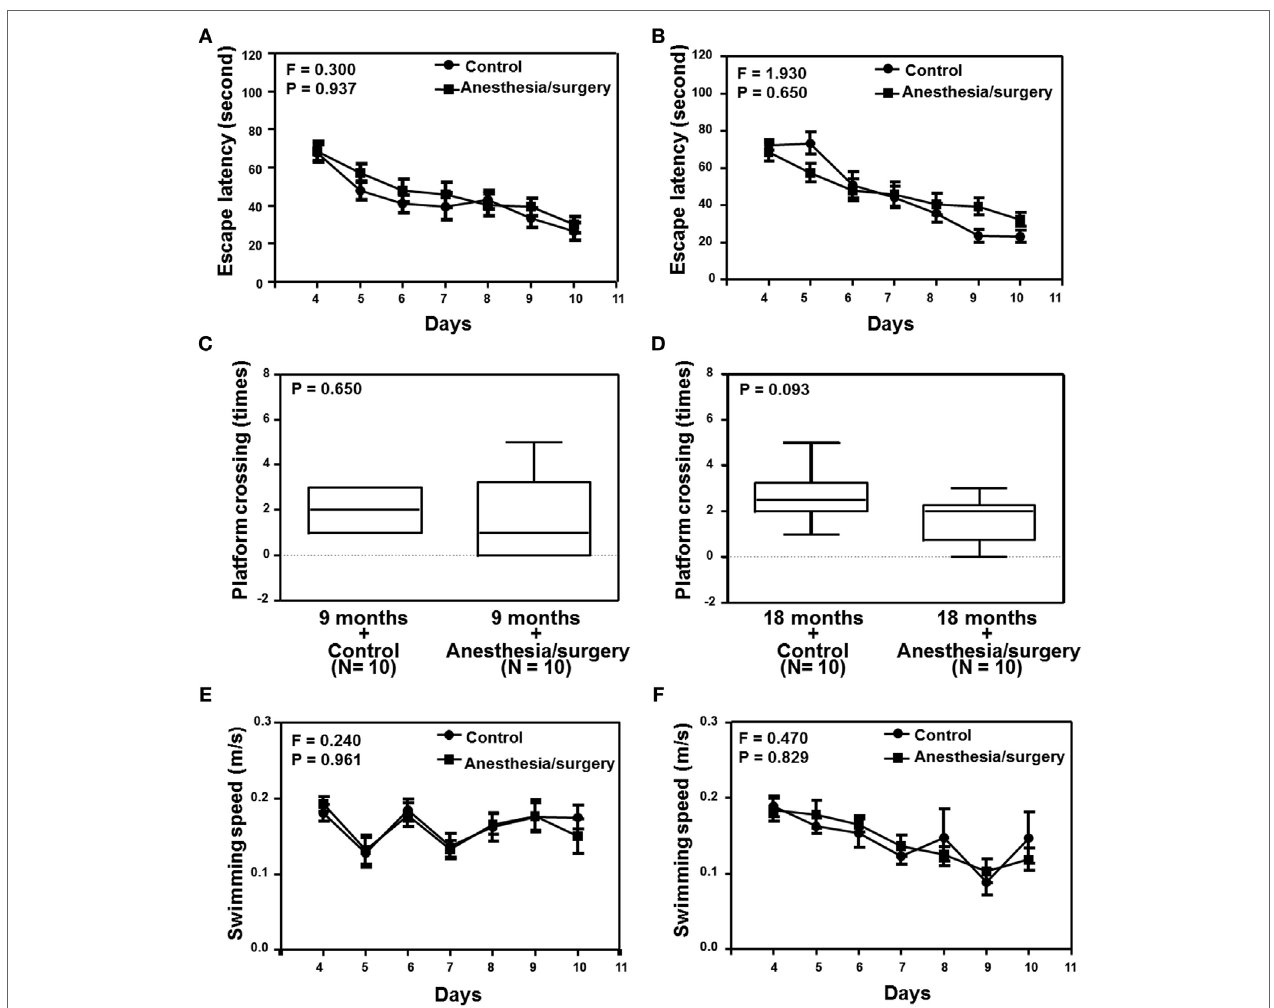
FigUre 5 | Effects of anesthesia/surgery on cognitive function in 9- and 18-month-old mice tested in MWM. The anesthesia/surgery does not significantly change the escape latency (a) , platform crossing times (c) , and swimming speed (e) of MWM as compared to the control condition in the 9-month-old mice. The anesthesia/surgery does not significantly change the escape latency (B) and swimming speed (F) of MWM as compared to the control condition in the 18-month- old mice. However, the anesthesia/surgery induces a borderline increase ( P = 0.093) in platform crossing times (D) of MWM as compared to the control condition in the 18-month-old mice. N = 10 in the control condition group and N = 10 in the anesthesia/surgery group. MWM, Morris water